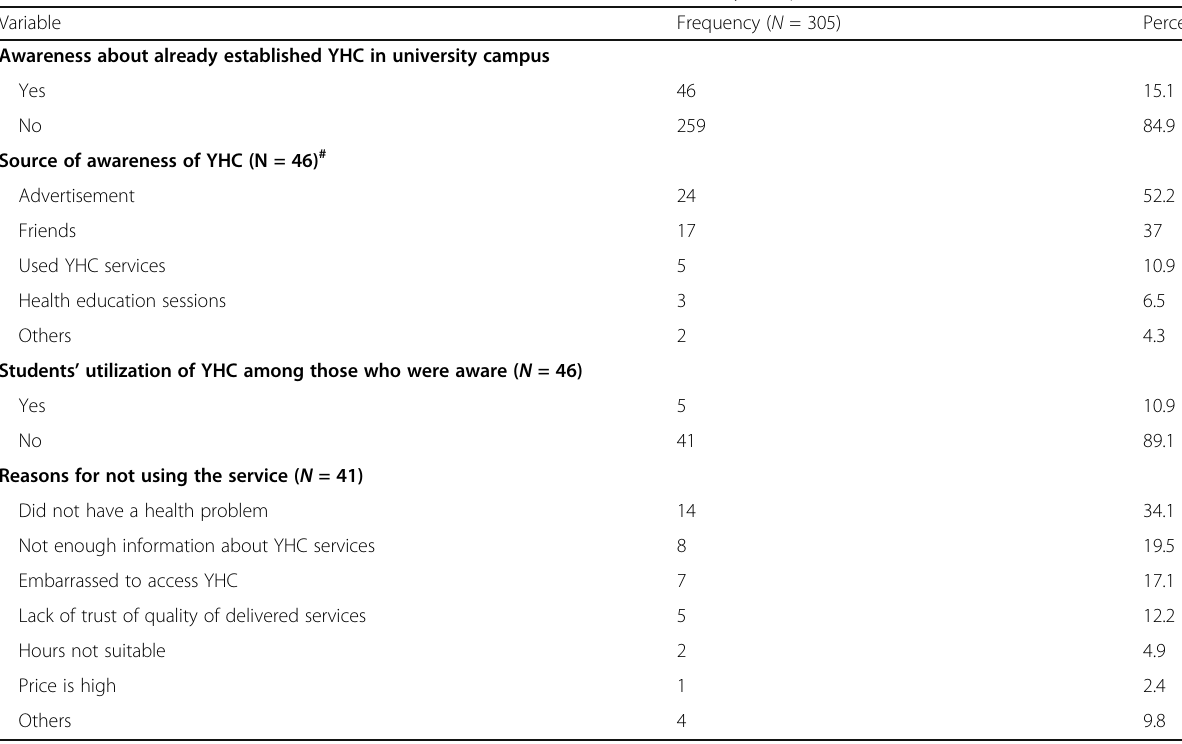
Table 4 Awareness of the students about the established YHC in Assiut University campus